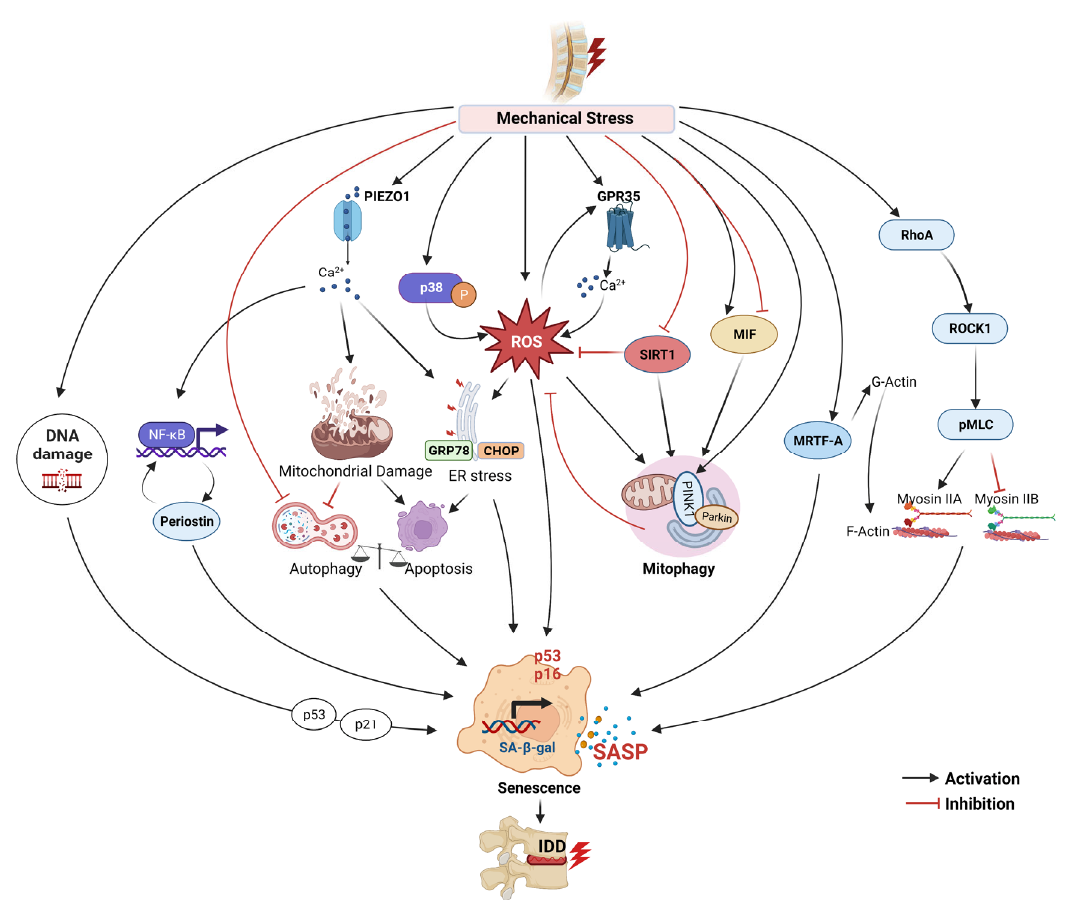
Figure 2. Proposed mechanisms of cellular senescence activation in the intervertebral disc by mechanical stress from reported fi ndings. Chronic abnormal mechanical stress is a major contributor of age-associated for IDD. Mechanical stress including compression or tensile forces can induce DNA damage leading to activation of the p53-p21 CIP1 senescence pathway. Mechanical stress